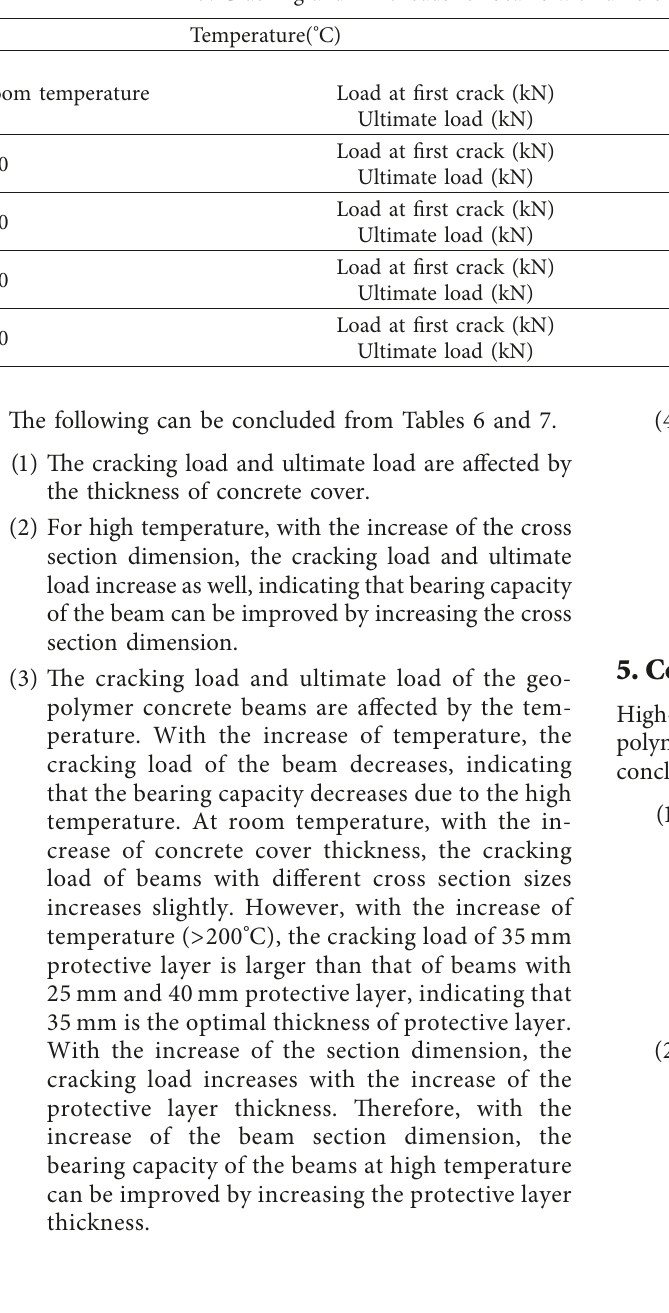
Table 7: Cracking and limit loads for beams with different concrete coverings (200 mm ×